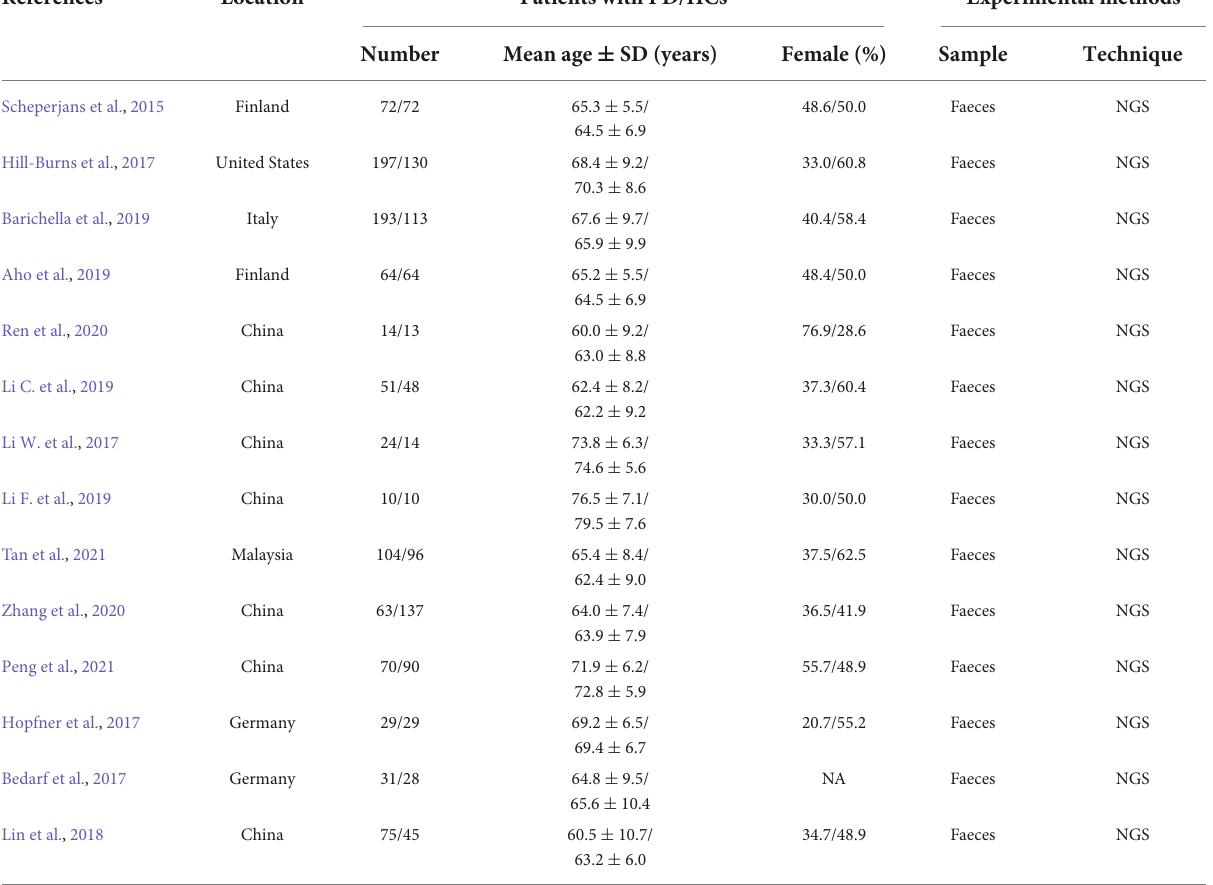
TABLE 1 Characteristics of the 14 studies included in the systematic